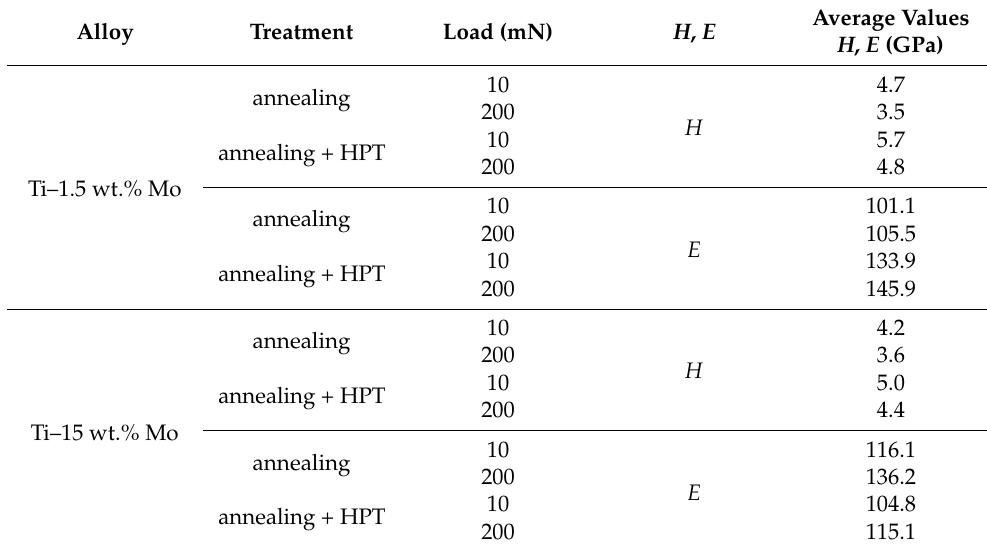
Table 3. Average values of the hardness and elastic modulus of the studied alloys before and after the HPT, depending on the load on the